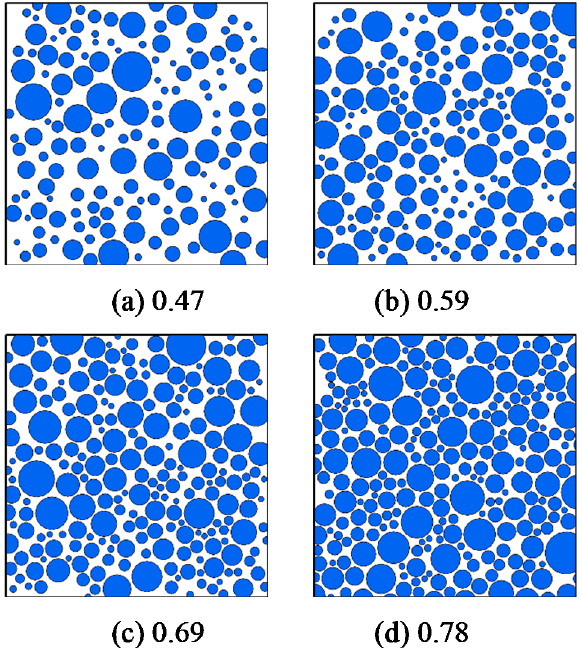
Figure 3. Mesoscale propellant filling models with different particle volume